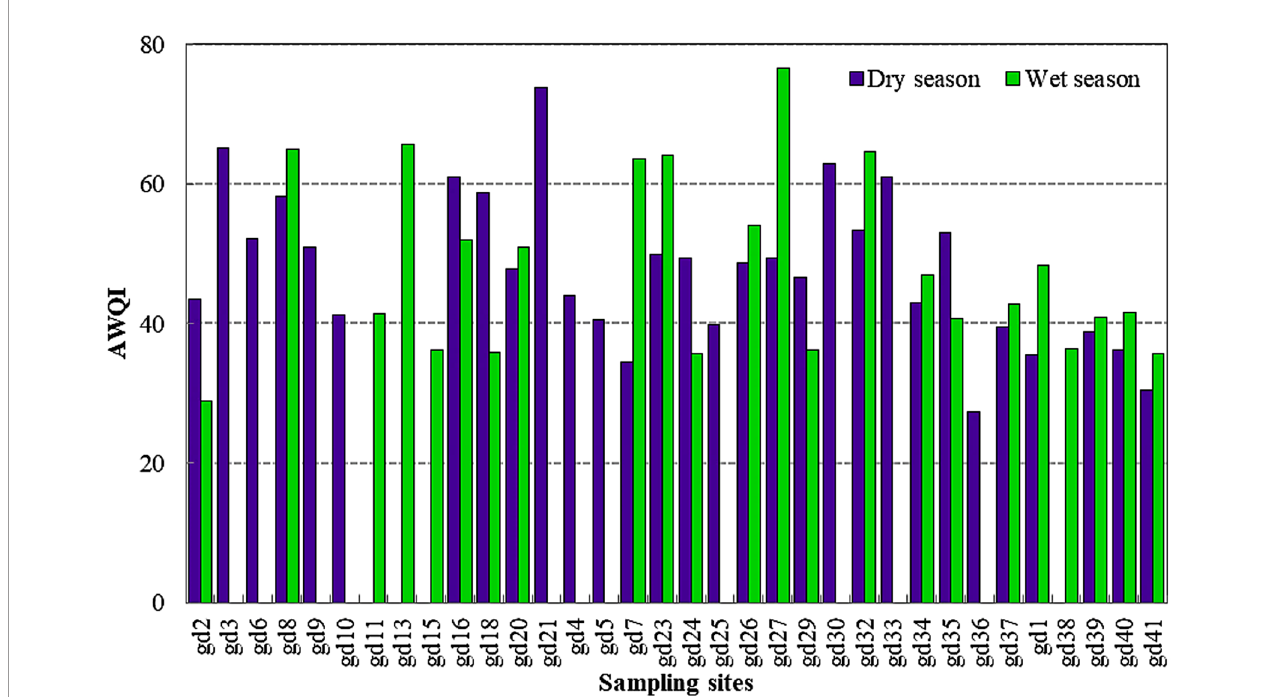
FIGURE 3 | Aquatic water quality index of the mangrove forest at different locations using the CCME method.